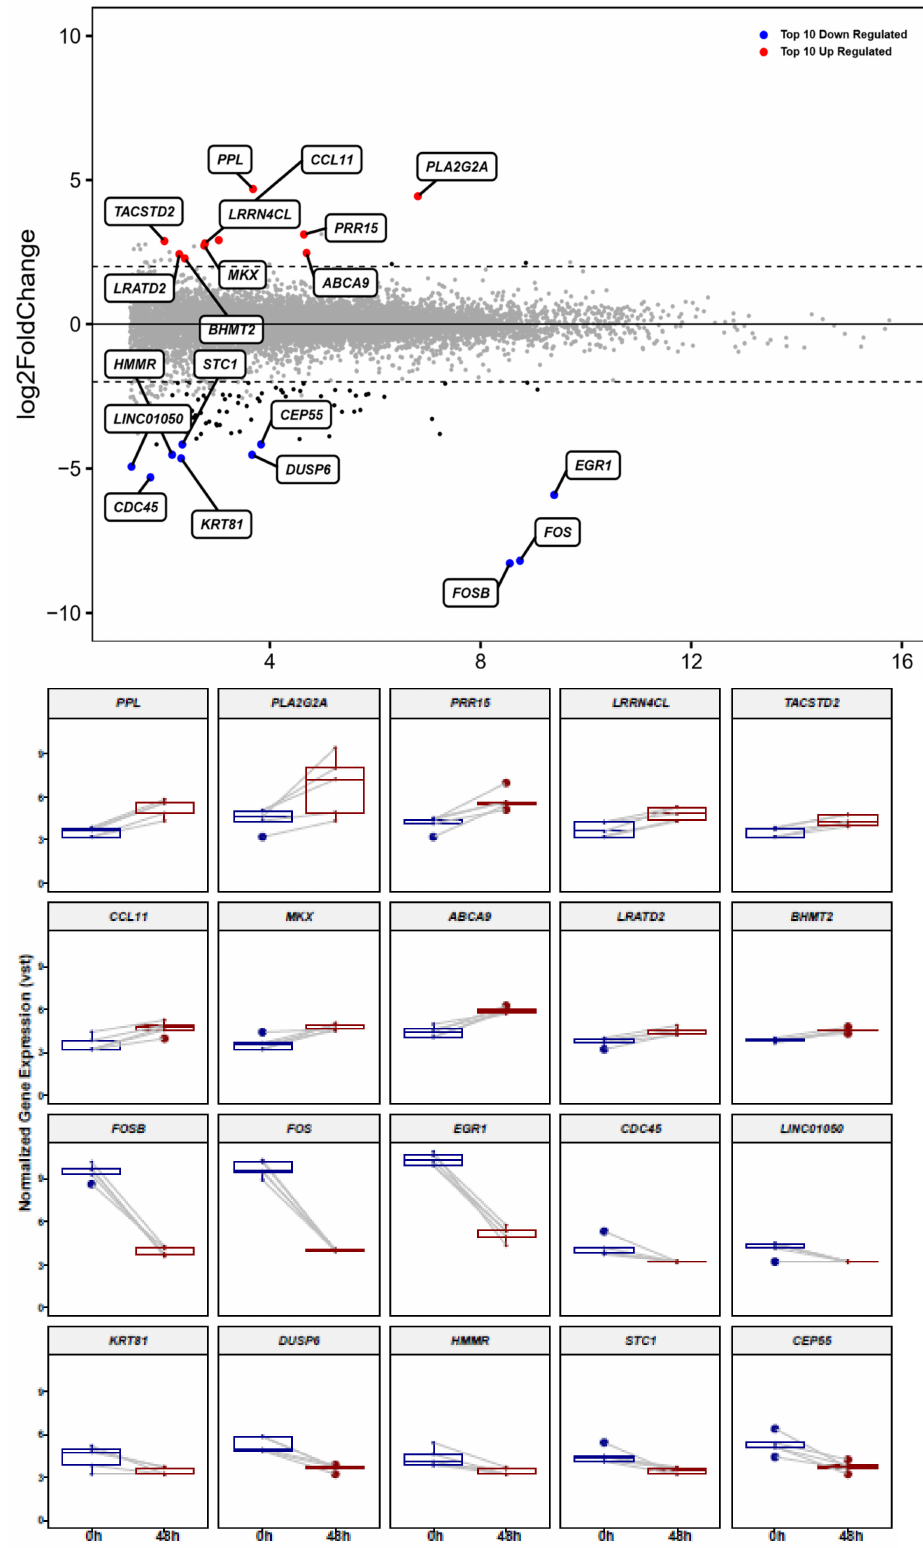
Figure 1. MA plot of the top 10 up- and downregulated (out of 101) differentially expressed genes (DEGs). The blue points represent downregulated and red points represents upregulated genes. The horizontal dashed line represents the statistical thresholds of DEGs (adjusted p -value < 0.05 and |fold change| >